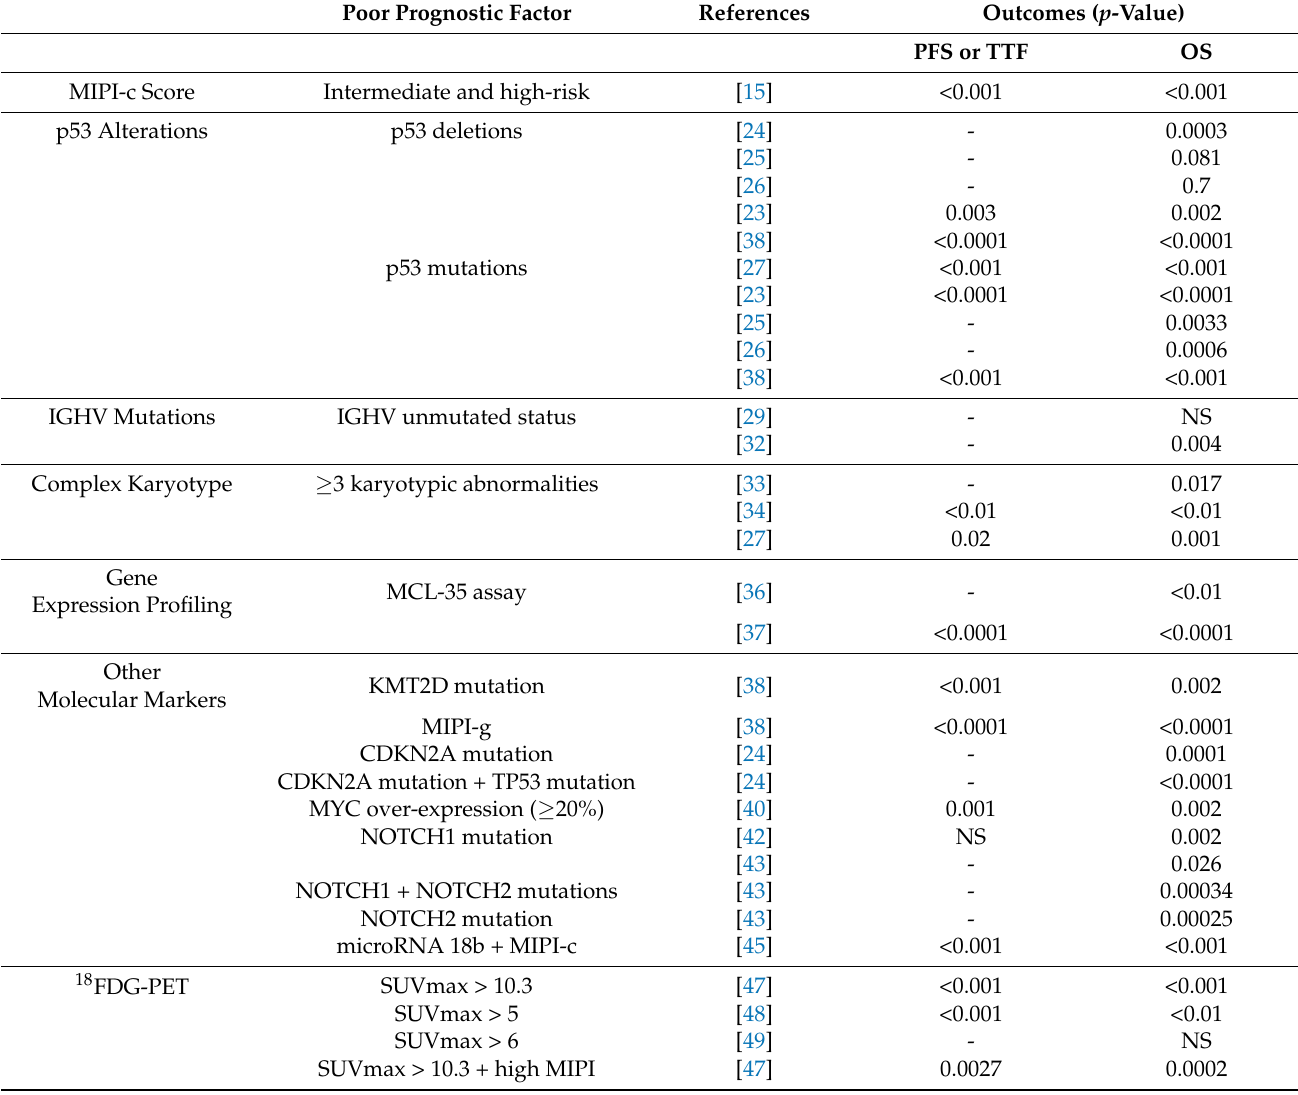
Table 1. Cont. Poor Prognostic